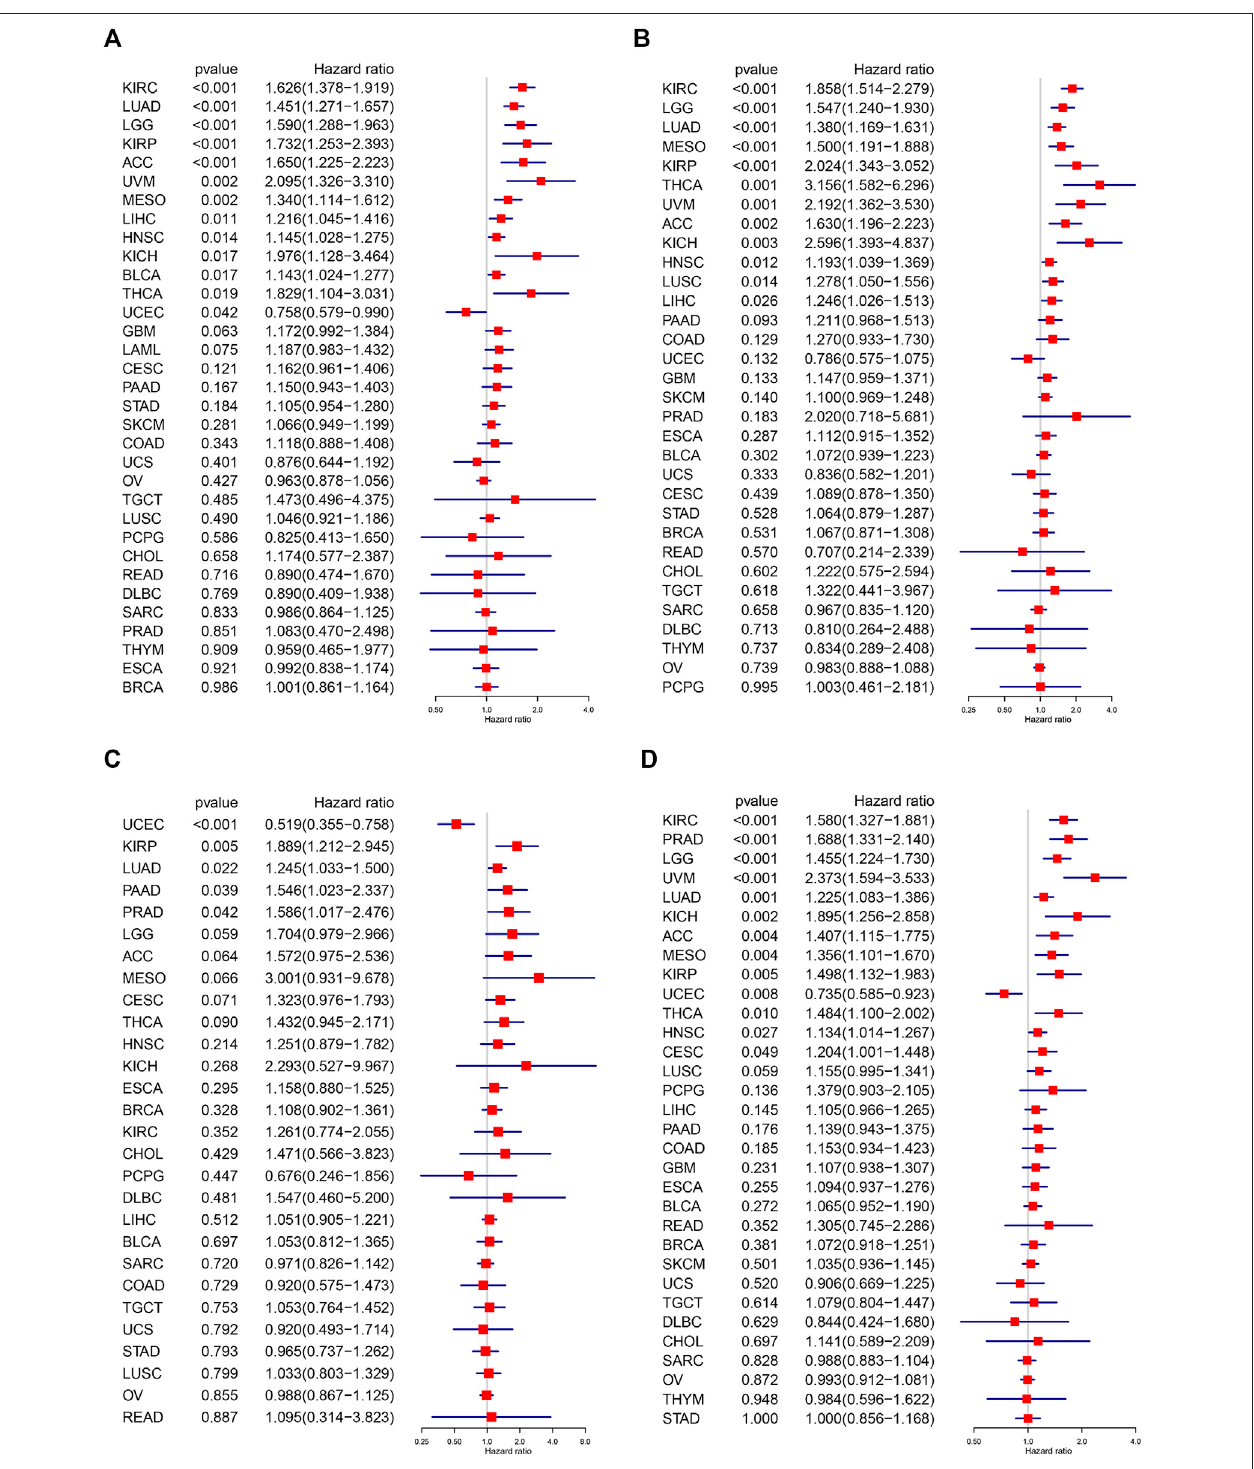
FIGURE 3 | Univariate Cox regression analysis of C1QTNF6. The results were shown with a forest map for (A) OS; (B) DSS; (C) DFI; (D) PFI.